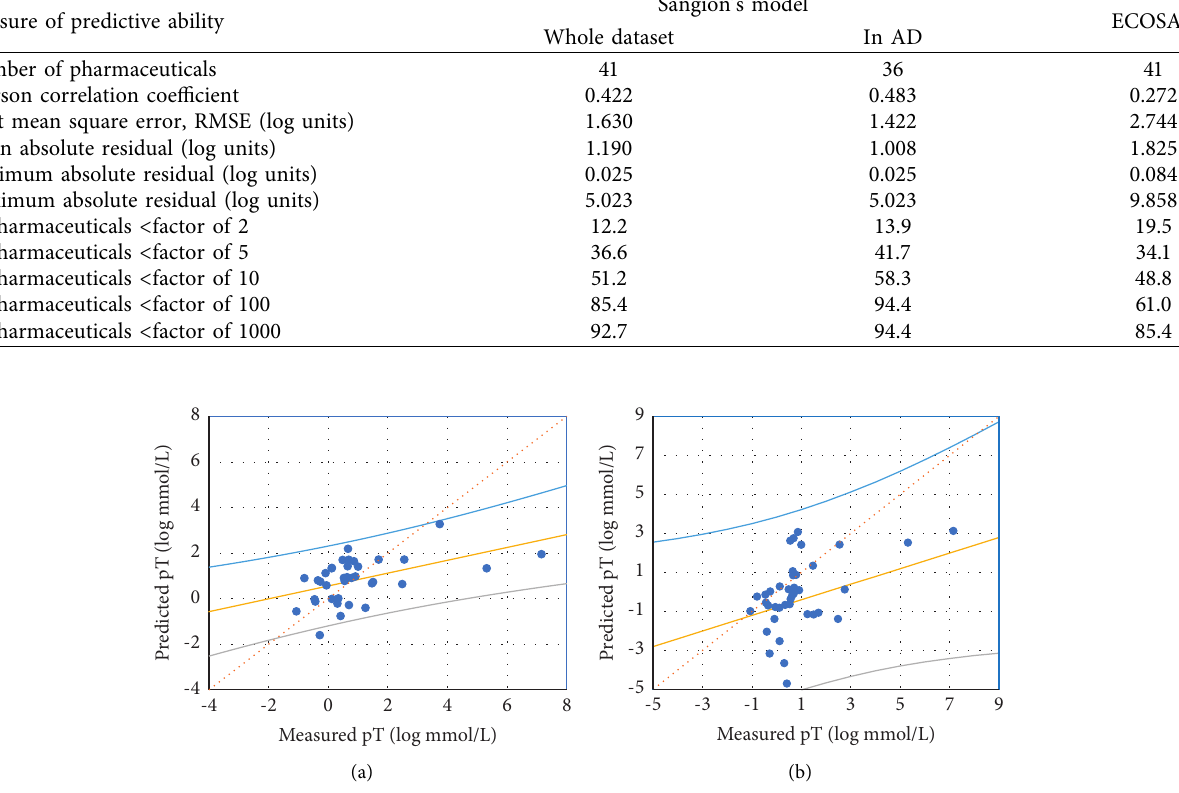
Figure 1: QSAR model predictions versus measured toxicity. The best-fit linear regression and 95% prediction intervals are shown. (a) Sangion’s model and (b) ECOSAR. Table 2: Summary statistics for the performance comparison of Tugcu’s model versus